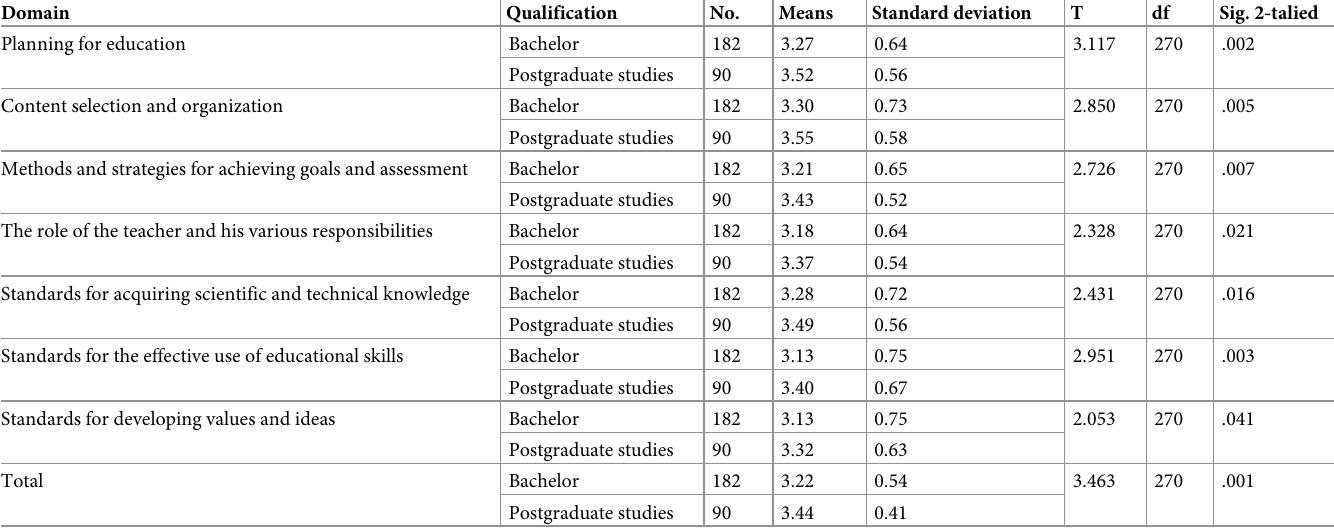
Table 6. T-test analysis for the quality assessment of the training programs for students with disabilities in light of modern trends attributed to academic qualification.